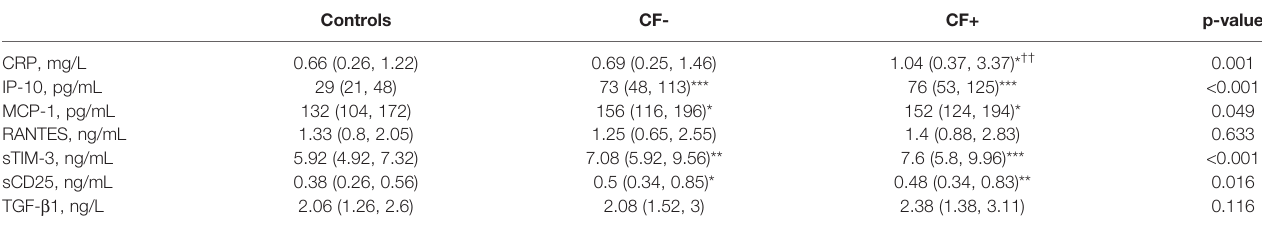
TABLE 3 | Plasma cytokines and in fl ammatory markers at baseline.